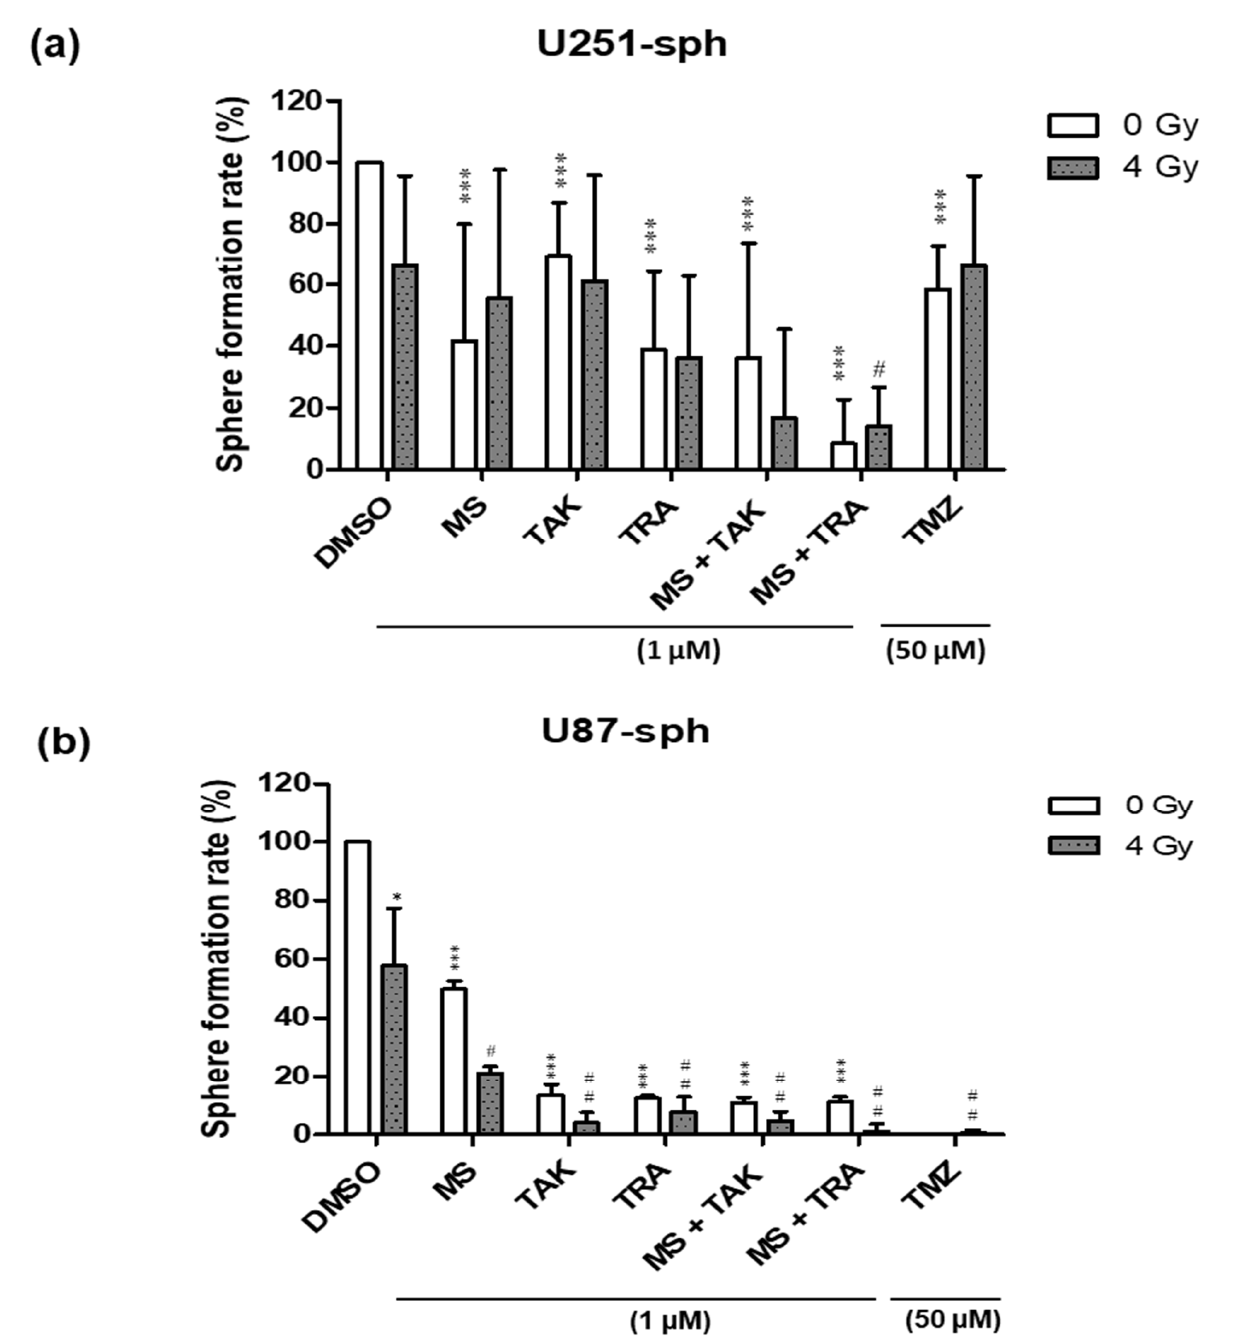
Figure 3. Treatment of HDAC and MEK inhibitors with radiation-inhibited sphere formation of GB- derived spheres. ( a ) Quantification of sphere formation rate (%) after the treatment of U251-sph and ( b ) U87-sph with HDCAi (1 µM MS-275 (MS)), MEKi (1 µM TAK-733 (TAK) or 1 µM trametinib (TRA)), a combination of both (1 µM MS-275 + 1 µM TAK-733 or 1 µM MS-275 + 1 µM trametinib) and 50 µM TMZ alone or with 4 Gy radiation. The sphere formation rate was normalized to the DMSO-treated cells as the control, which were set to 100%. Data represent the mean of 3 independent experiments performed in triplicates ( n = 3; ± SEM). Asterisks indicate significant differences between 0 Gy DMSO and treated samples using Student’s t -test: * p ≤ 0.05 and *** p ≤ 0.001, while hash symbols indicate significant differences between 4 Gy DMSO and 4 Gy treated samples using Student’s t -test: # p ≤ 0.05 and ## p ≤ 0.01.